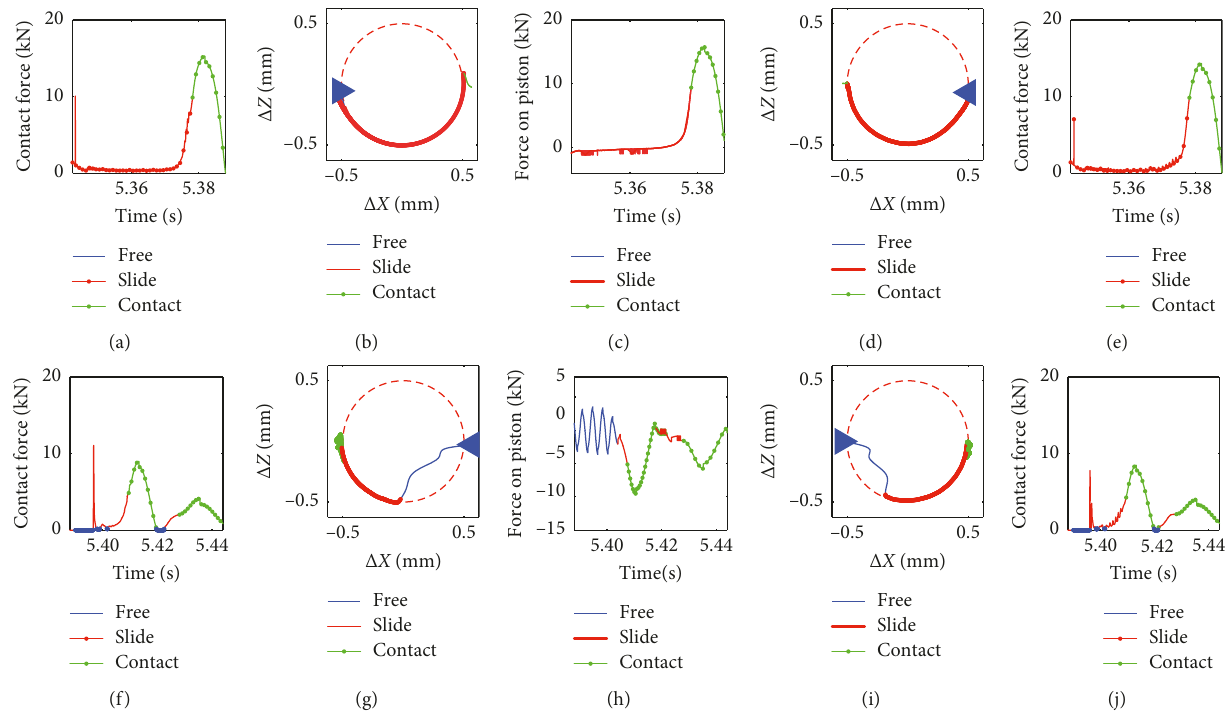
Figure 18: Contact forces, trajectories, and forces on the piston in the numerical study with c left journal; (b, g) trajectories in the left journal; (c, h) forces on the piston; (d, i) trajectories in the right journal; (e, j) contact forces in the right